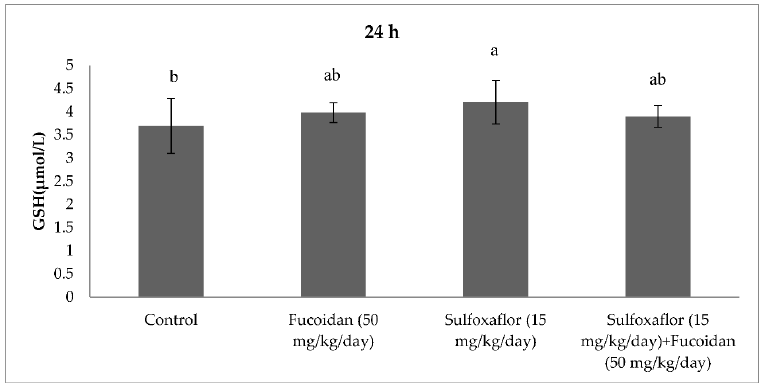
Figure 7. Effects of Sulfoxaflor and Fucoidan on GSH Levels (µmol/L)) in Serum of Mice at 24-h Treatment Periods. Values are expressed as mean ± standard error. Glutathione: GSH. Letters a and b show the differences between treatment groups and control. Data shown in different letters are significantly different at p < 0.05 level ( n = 8). Duncan multiple comparison tests were used.